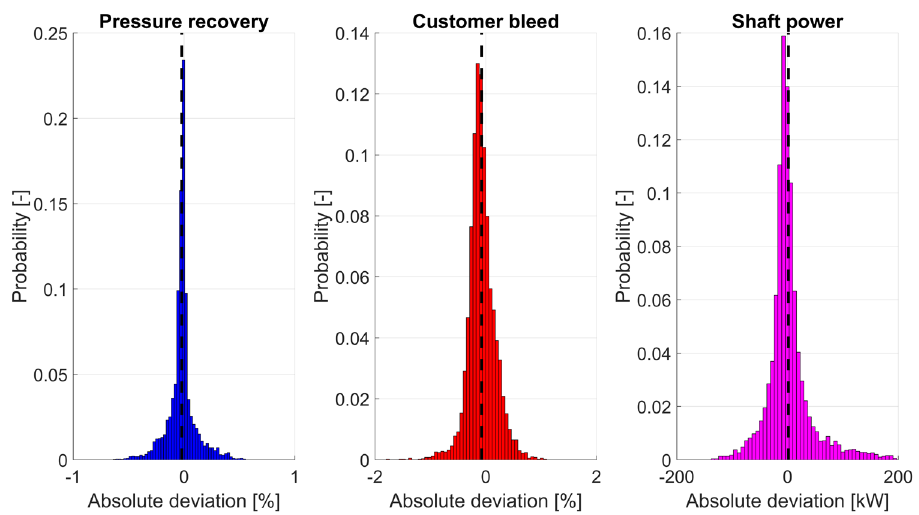
Figure 12. PDF of the error in the estimated installation effects, without measurement noise.